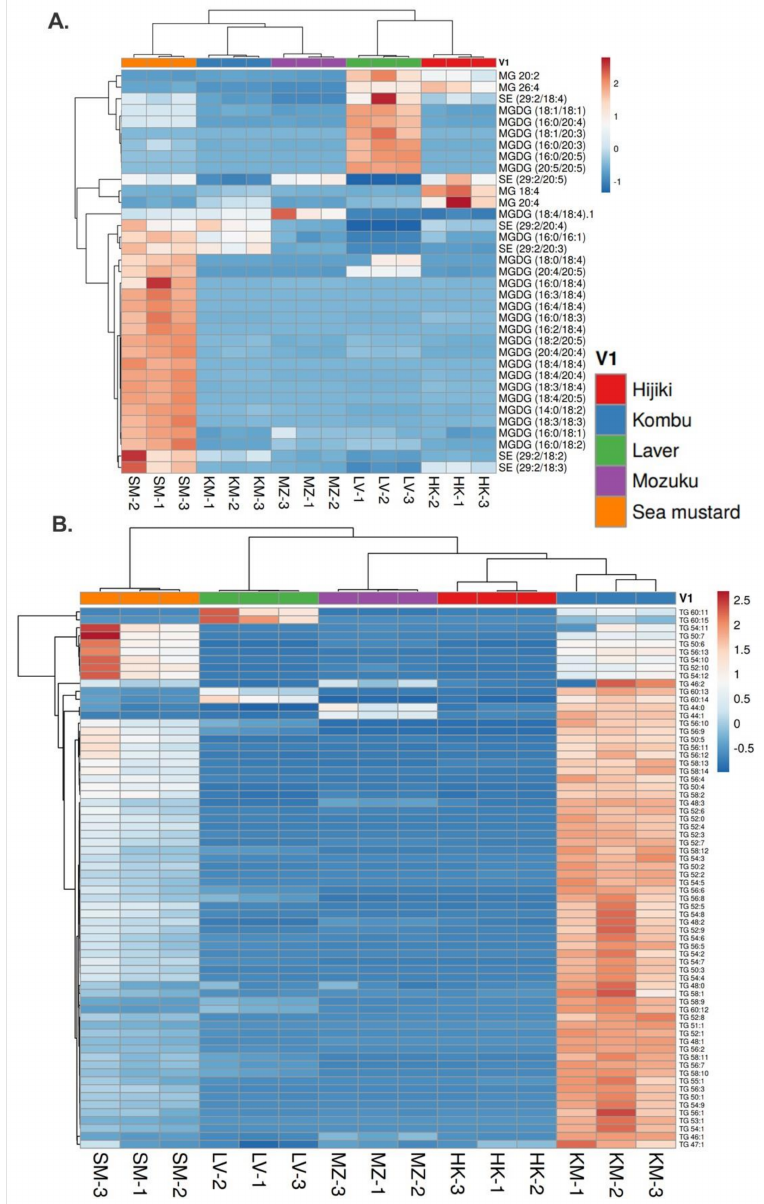
Figure 4. Hierarchical cluster correlation heatmap of glycerolipids and sterols. ( A ) Monoglycerols (MG), monogalactosyldiacylglycerol (MGDG), and stigmasterol (SE). ( B ) Triacylglycerols (TGs). HK: Hijiki, KM: Kombu, LV: Laver, MZ: Mozuku, SM: Sea mustard. The MGDGs and SEs are relatively higher in sea mustard and laver (Figure